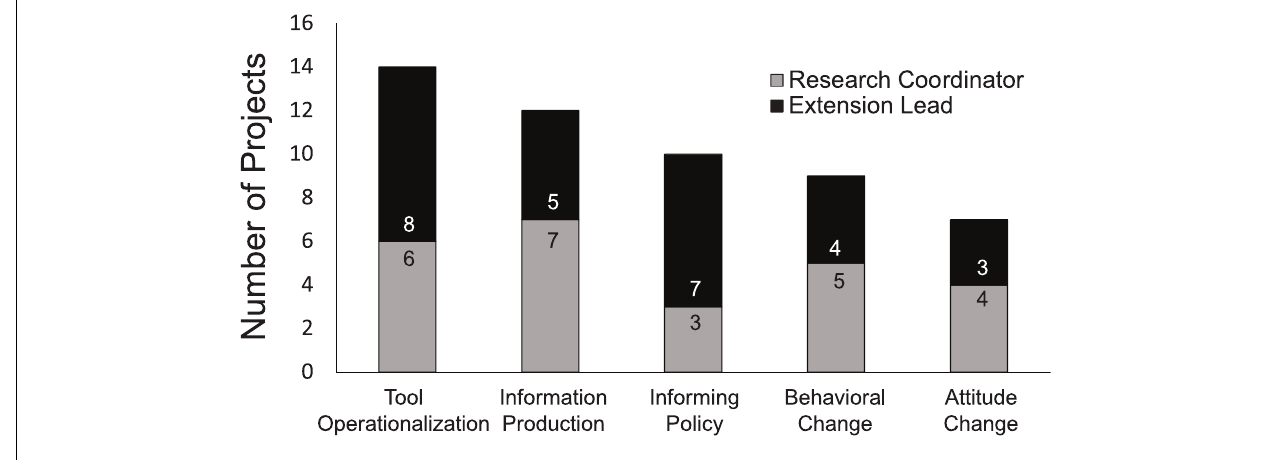
FIGURE 3 | The 52 examples of ‘successful’ research to application (R2A) projects identified by Research Coordinators (RCs) and Extension Leads (ELs) categorized by their most salient deliverable. Projects identified by RCs are in gray while projects identified by ELs are in black. The five categories are: tool operationalization, information production, informing policy, behavioral change, and attitude change. Numbers within bars represent how many projects fall into each